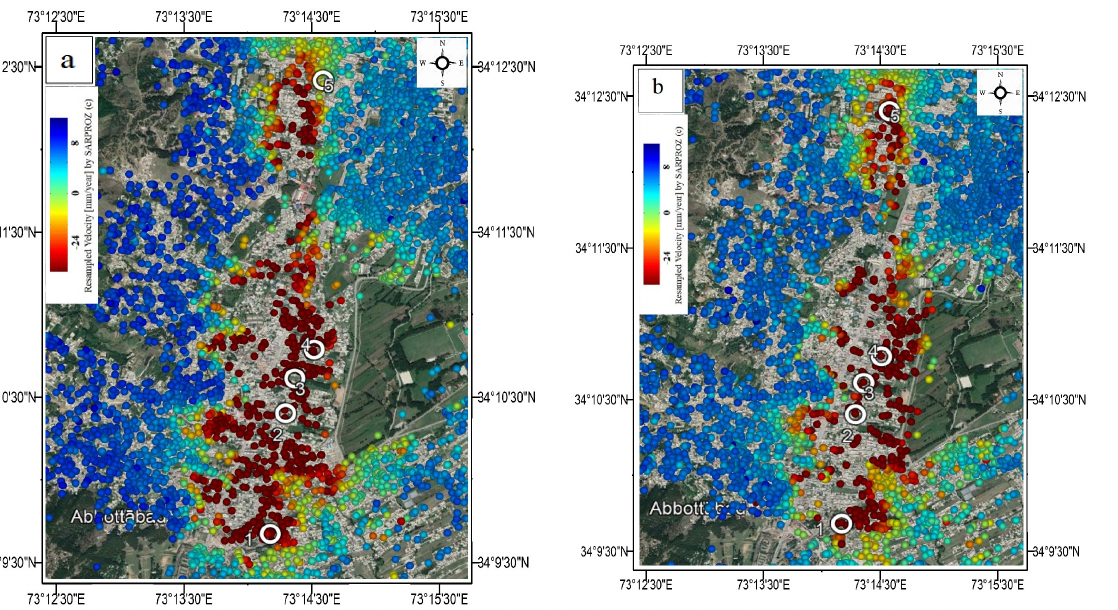
Figure 9. PS points (P1, P2, P3, P4, and P5) selected in descending track ( a ) and ascending track ( b ). The subsidence along these five PS points were analyzed, which show variations in subsidence from 2017 to 2019. The graphic representations of these five points are given in Figure 10. The graphs clearly show that points 2, 3 and 4 have high subsidence and are located in the central part of study area, while point 1 and point 5 have comparatively low subsidence during study period.